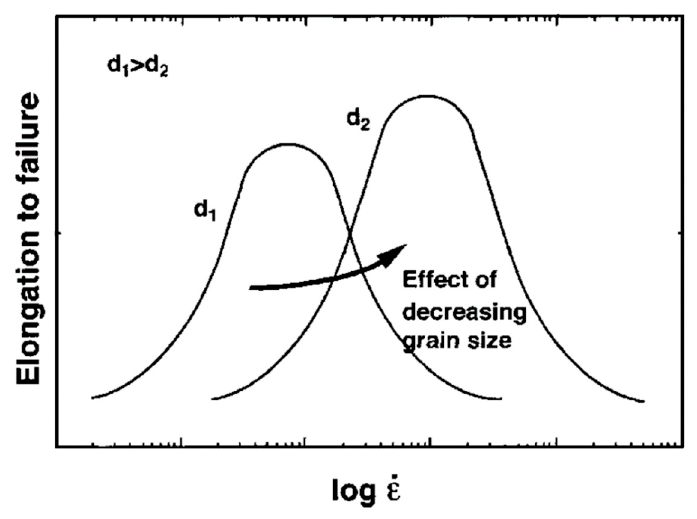
Figure 7. Schematic illustration of elongation to failure versus strain rate showing the effect of decreasing the grain size [35].